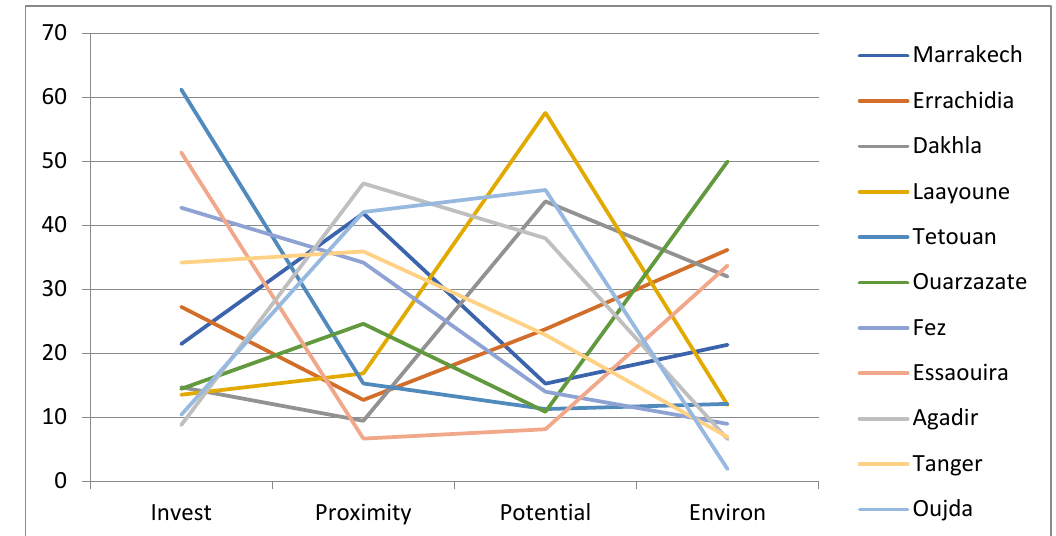
Figure 3. Central weights for alternatives sorted according to their acceptability indices.